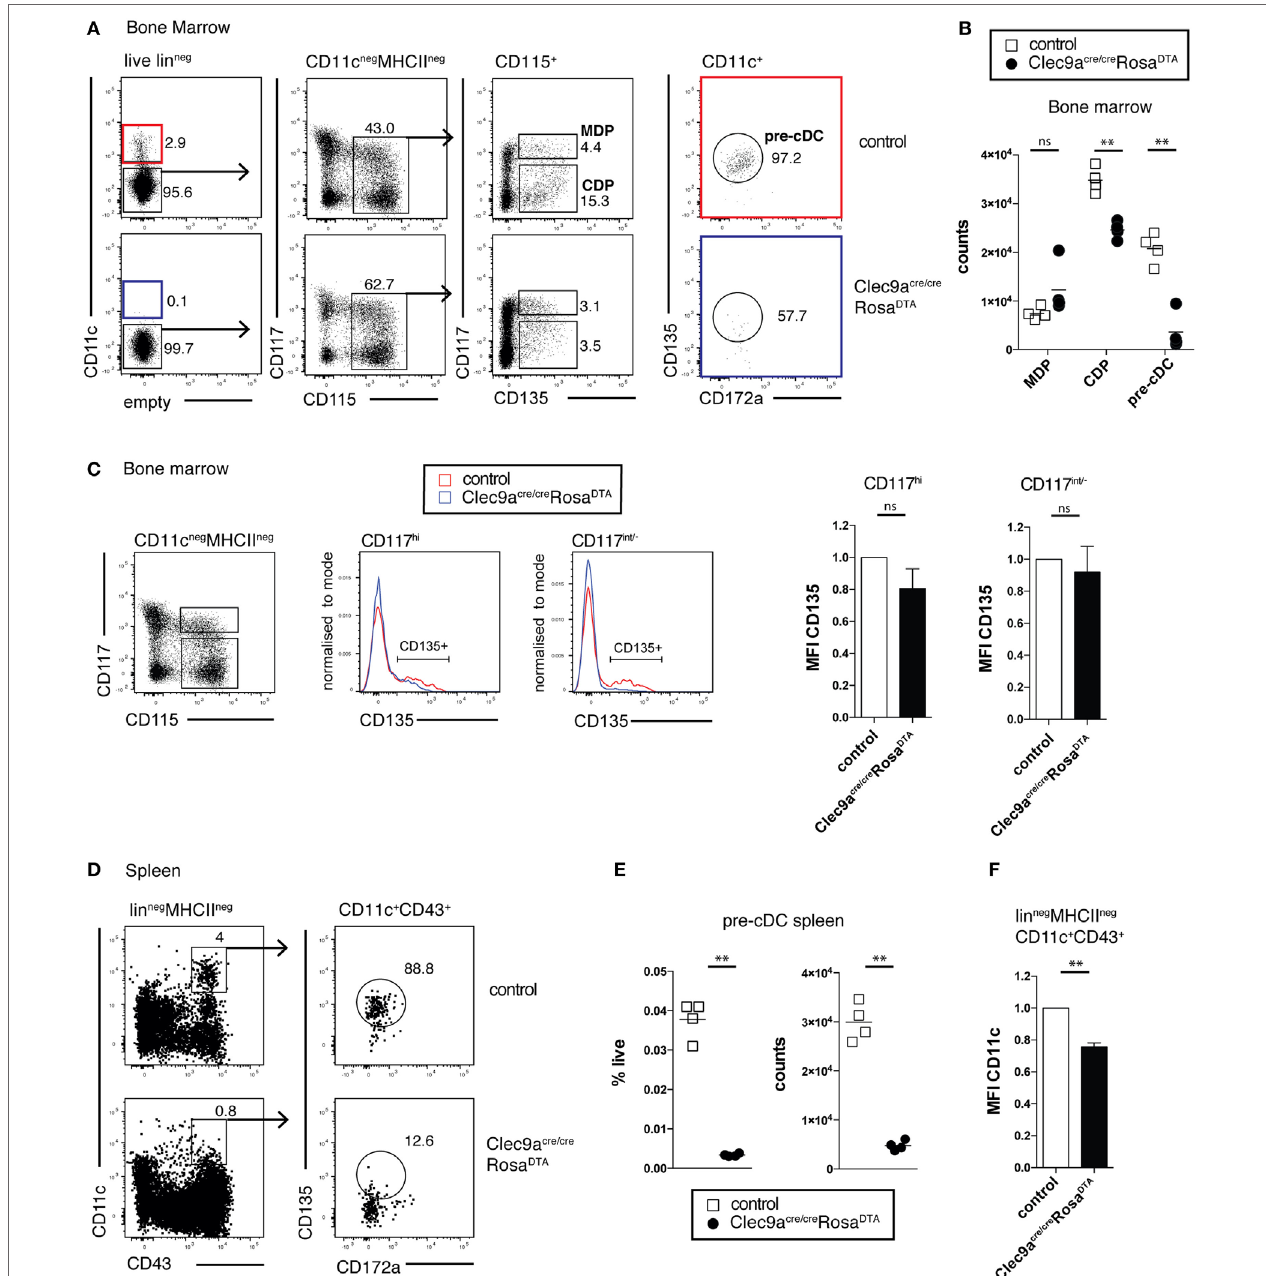
FigUre 3 | Efficient depletion of conventional dendritic cell (cDC) progenitors in bone marrow and spleen. (a,B) cDC progenitors were identified by flow cytometry in the bone marrow of 10-week-old control and Clec9a cre/cre Rosa DTA mice. (a) Live lineage negative (lin − ; CD3, CD4, CD8, CD11b, MHCII, Ter119, NK1.1, and B220) cells were gated and further analyzed for CD11c, CD117, CD115, CD172a, and CD135 expression. Macrophage and DC progenitor (MDPs) were identified as CD11c − CD115 + CD135 + CD117 hi cells, common DC progenitors (CDPs) as CD11c − CD115 + CD135 + CD117 int/ − cells, and pre-cDCs as CD11c + CD172a int CD135 + cells. (B) The number of MDP, CDP, and pre-cDC per femur is shown. (c) Lin − CD115 + CD117 hi and lin − CD115 + CD117 int/ − bone-marrow cells from control and Clec9a cre/cre Rosa DTA mice were gated and further analyzed for CD135 expression. Mean fluorescence intensity (MFI) ( n = 4) of the CD135 + cell fraction, as gated in the histogram overlays, is shown. It was normalized to MFI on the same population from control mice, which is set as 1. (D–F) Pre-cDCs in spleen from control and Clec9a cre/cre Rosa DTA mice 10 weeks of age were identified as lin − CD11c + CD43 + CD172a int CD135 + cells by flow cytometry (D) . (e) The frequency and number of pre-cDCs per spleen is shown. (F) CD11c MFI on splenic lin − MCHII − CD11c + CD43 + cells from Clec9a cre/cre Rosa DTA mice is shown. It was normalized to MFI on the same population from control mice, which is set as 1 ( n = 4). Each symbol represents one mouse. ns, not significant; * p < 0.05, ** p < 0.001, and *** p <